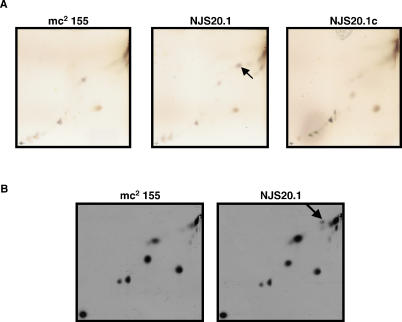
Two-Dimensional TLC Analysis of the Polar Lipids Extracted from M. smegmatis Strains(A) Two-dimensional TLC of polar lipid fractions from wild-type M. smegmatis Mc2155, lsr2 transposon mutant NJS20.1, and complemented strain NJS20.1c. The solvent system is as follows: first dimension, chloroform/methanol/water (60/30/6); second dimension, chloroform/acetic acid/methanol/water (40/25/3/6). The spots were visualized with orcinol. The black arrow marks the spot present in the NJS20.1 mutant and not in either the control or the complemented strain.(B) The cells were grown to log phase and labeled with [1-14C]-acetate. The black arrow indicates the new lipid.